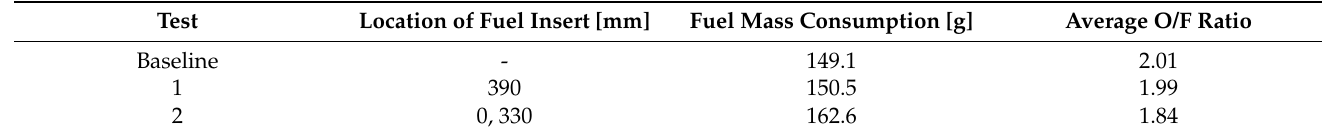
Table 1. Summary of test conditions.